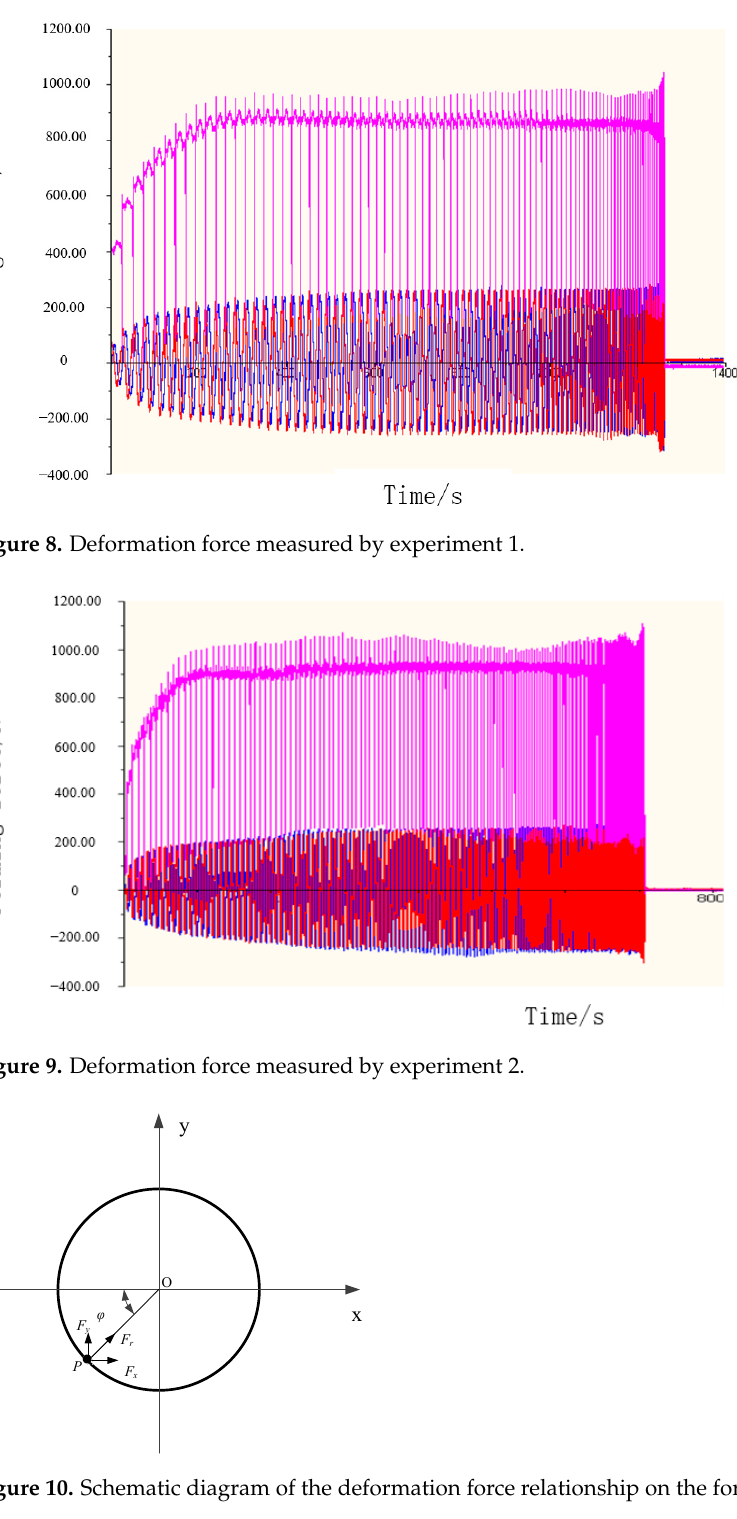
Height/mm −5 Figure 11. Radial and axial deformation forces of specimen 1.